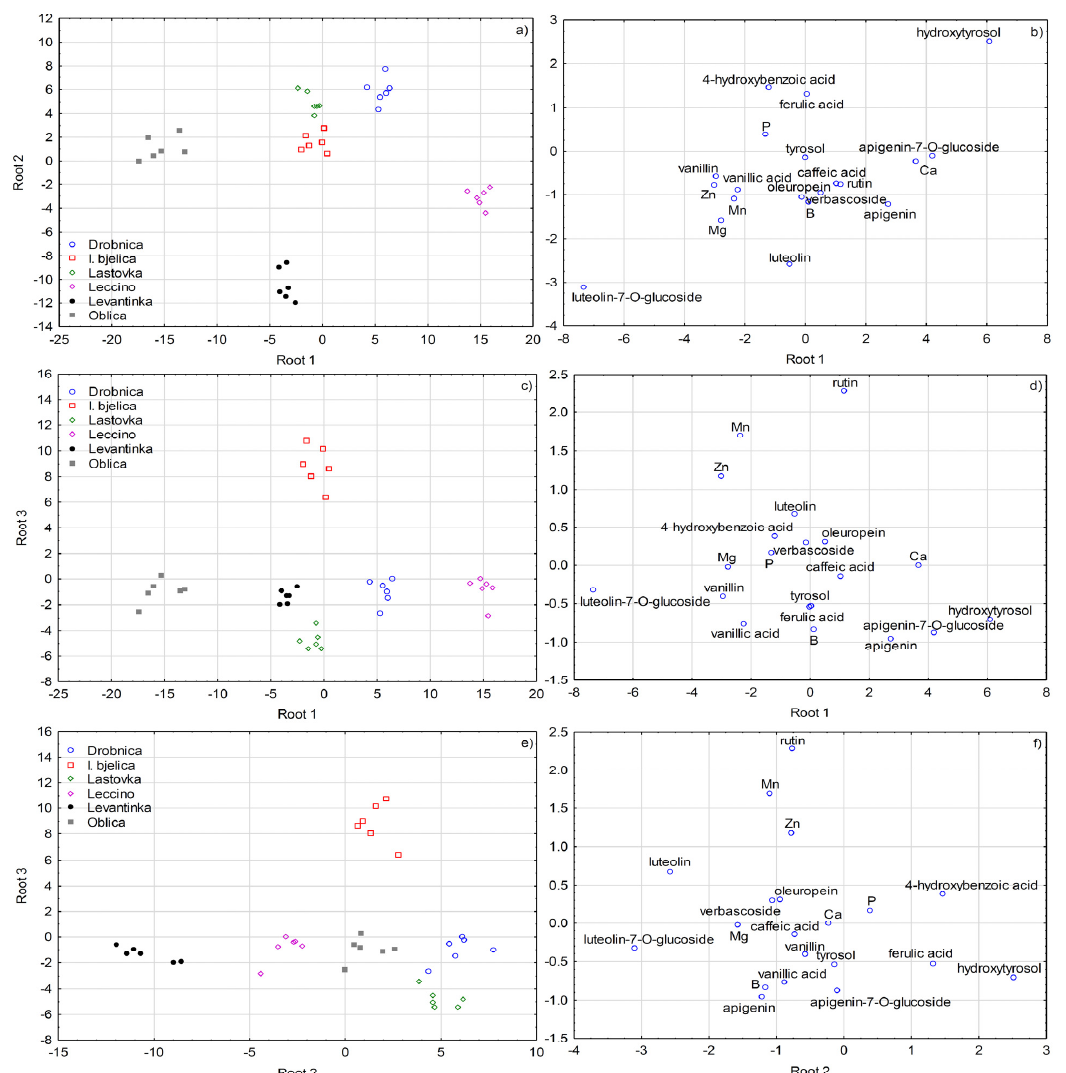
Figure 3. ( a , c , e ) Separation of olive leaves according to cultivar defined by the first three discriminant functions (roots) obtained by forward stepwise discriminant analysis (SLDA). ( b , d , f ) Standardized coefficients of biophenols and mineral nutrients selected by SLDA on the first three discriminant functions (roots). functions